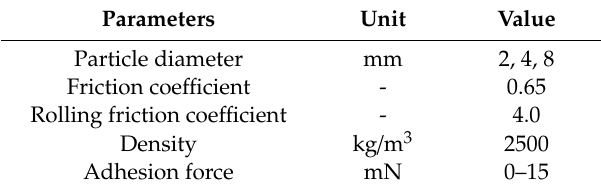
Table 2. Simulation conditions for the test of angle of repose.